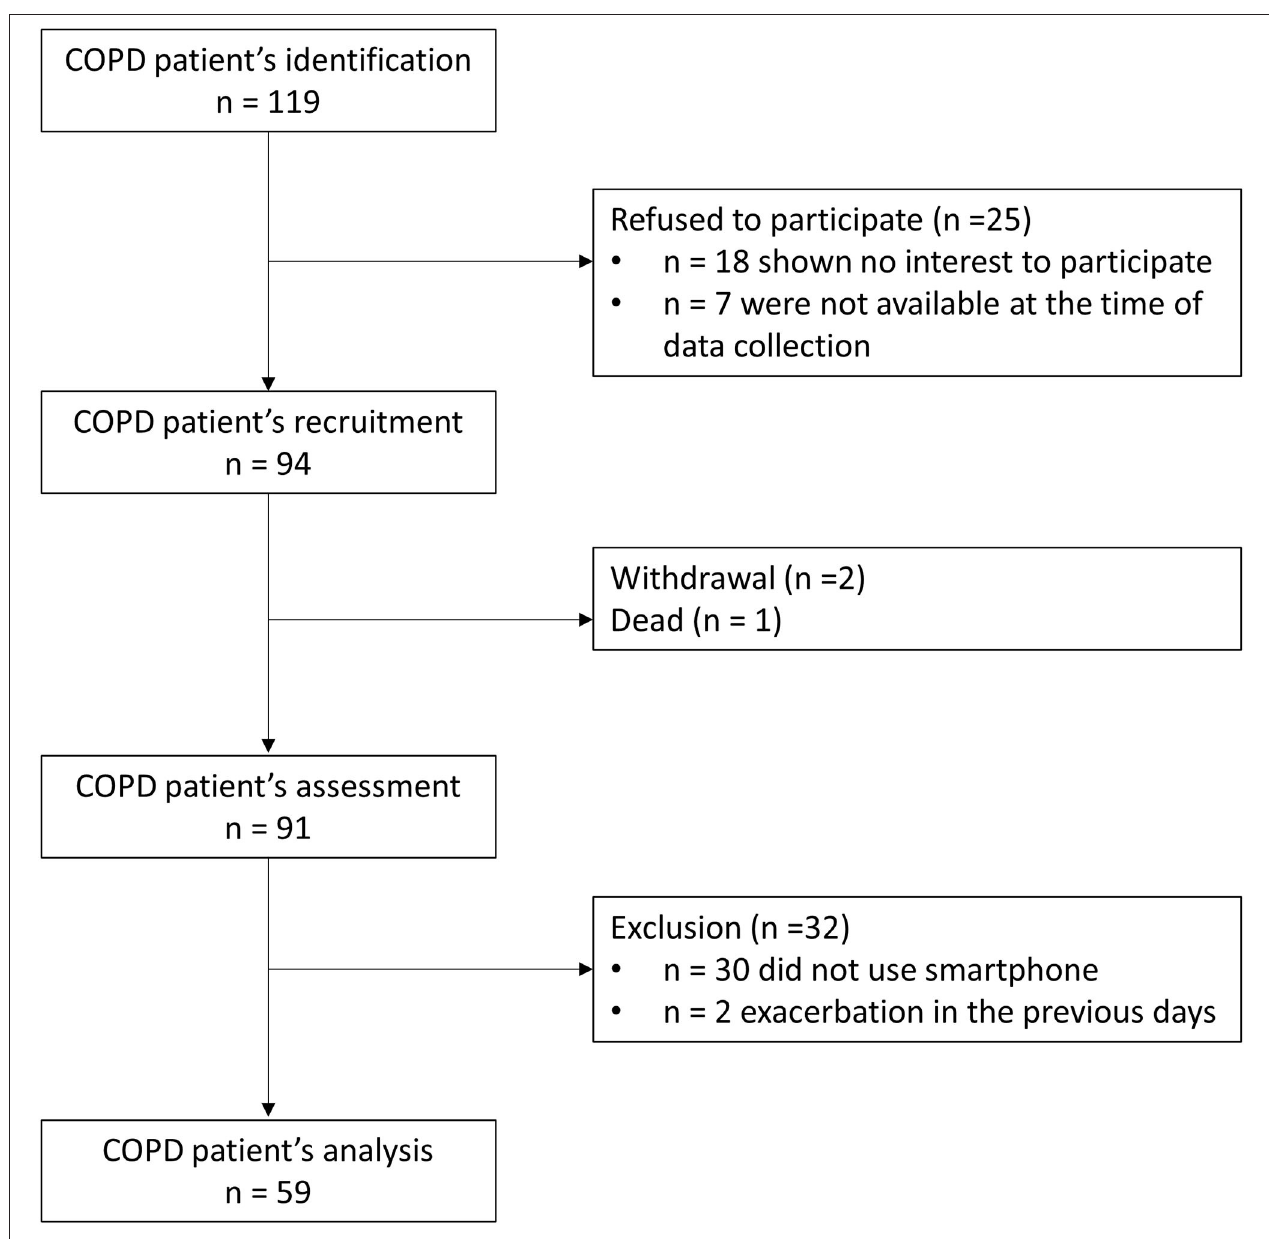
FIGURE 1 | Flow chart of the participants’